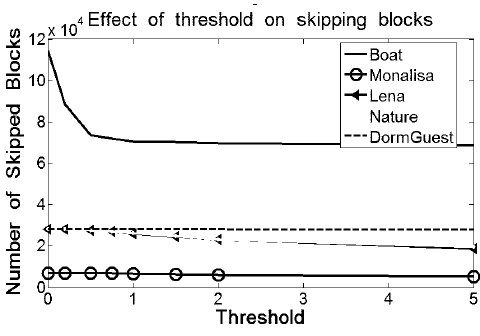
Figure 6. Effect of threshold in skipping blocks.